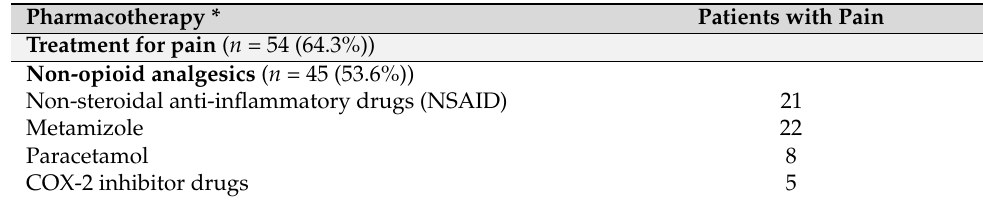
Table 2. Data referring to the medication of the 84 pain patients regarding the treatment for pain as well as the treatment for cramps and spasticity. Values are given as number of patients (%). Pharmacotherapy * Patients with